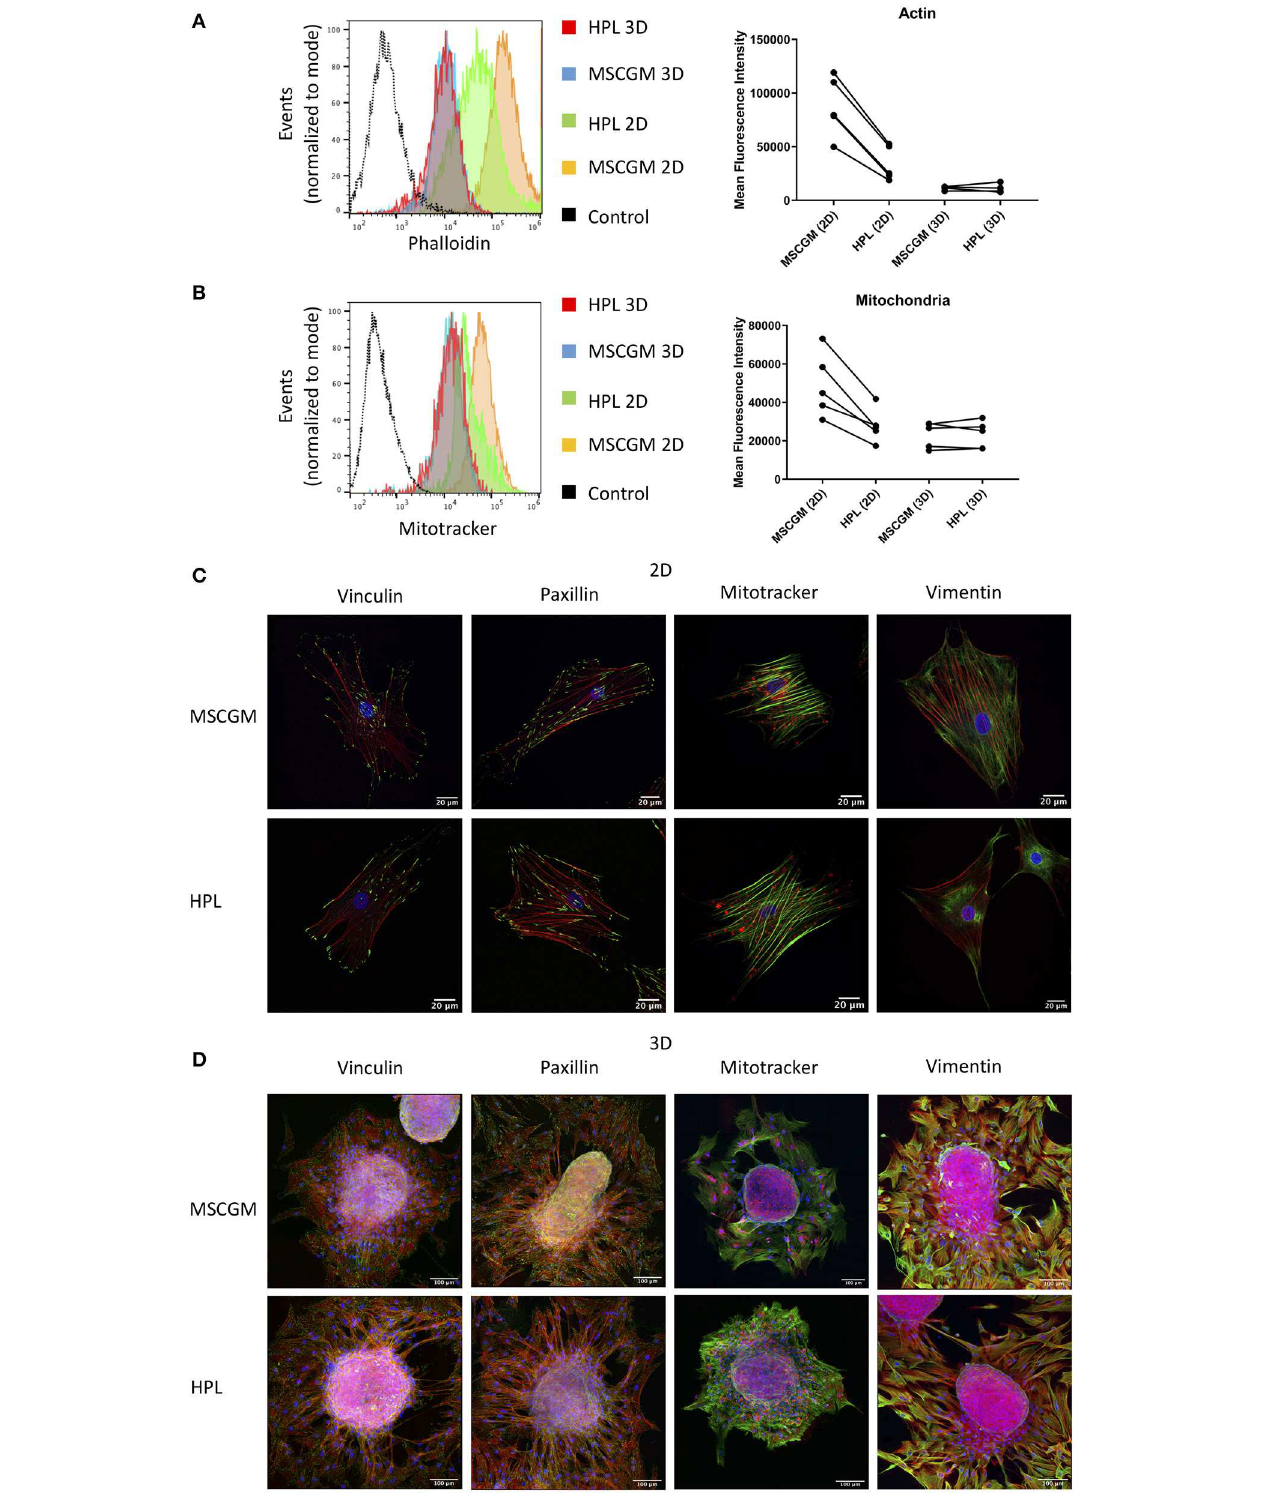
FIGURE 1 | Effect of HPL on 2D and 3D cultures. (A) Actin measurements with phalloidin of living CD90 + MSCs in 2D vs. 3D cultured in MSCGM TM or MSCBM TM with 8% HPL determined by flow cytometry. Dot plot of the mean fluorescence intensity of four different batches for 3D MSCs and five batches for 2D